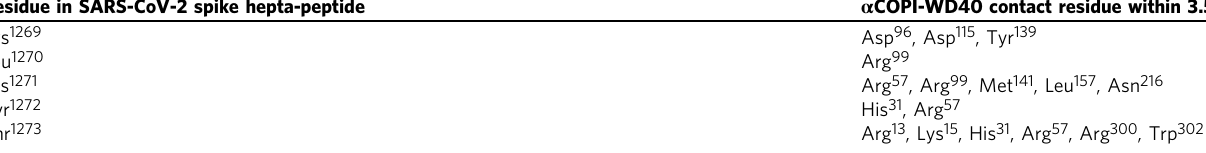
Table 3 Interaction residues in in silico model of spike hepta-peptide with α COPI-WD40. Residue in SARS-CoV-2 spike hepta-peptide